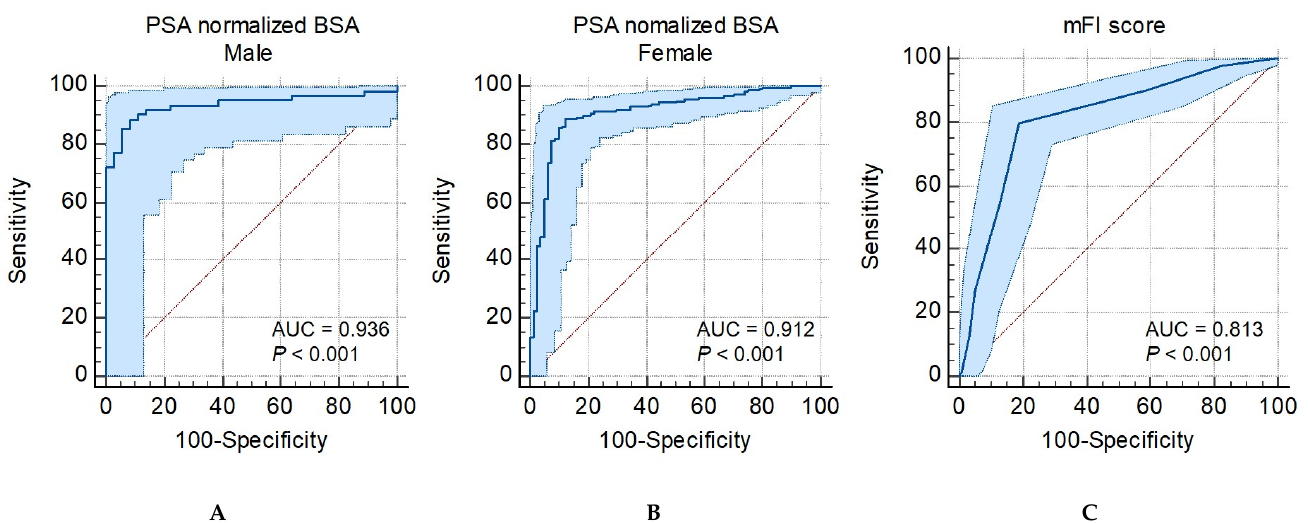
Figure 3. Receiver-operating characteristic curves for discriminating intraoperative hypotension ROC curve for predicting IOH using ( A ) PSA normalized by BSA in male patients, ( B ) PSA normalized by BSA in female patients, and ( C ) mFI score. ROC; receiver operating characteristic AUC; area under the curve; IOH, intraoperative hypotension; PMA, psoas muscle area; BSA, body surface area; mFI, modified frailty index.